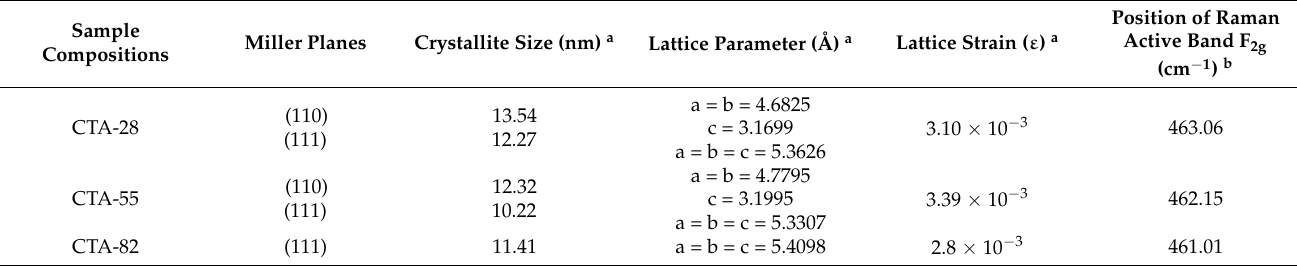
Table 2. Microstructural properties of CTA-55.